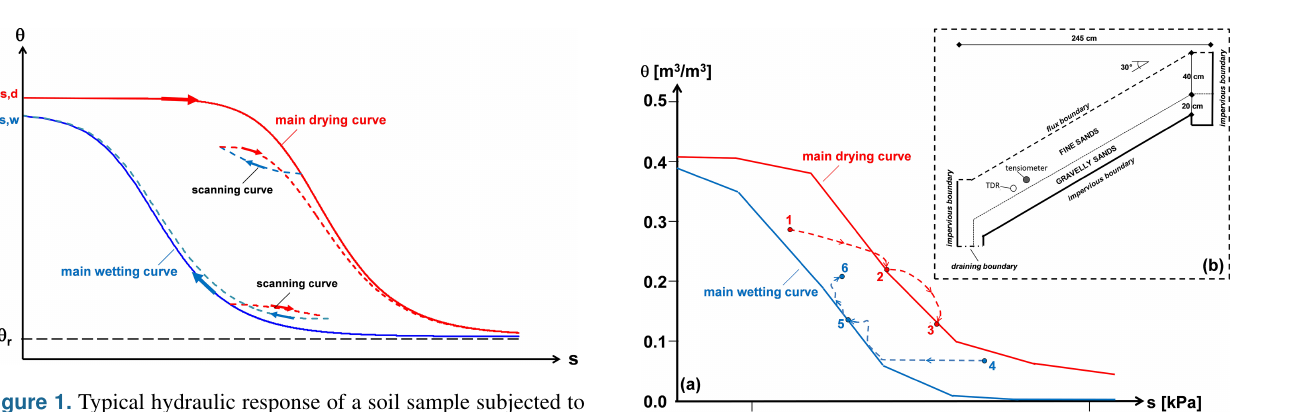
Figure 1. Typical hydraulic response of a soil sample subjected to drying and wetting cycles. Along the main drying curve, the vol- umetric water content, θ , continuously decreases with the matric suction, s , from the initial saturated value, θ s, d , until the minimum residual value, θ r , is reached. Along the main wetting curve, θ con- tinuously increases from the initial residual value, θ r , until the final maximum value, θ s, w , is reached at s = 0. If the continuous main drying (wetting) stage is interrupted by a reverse wetting (drying) process, a different scanning curve, located under (over) the main path, is travelled.